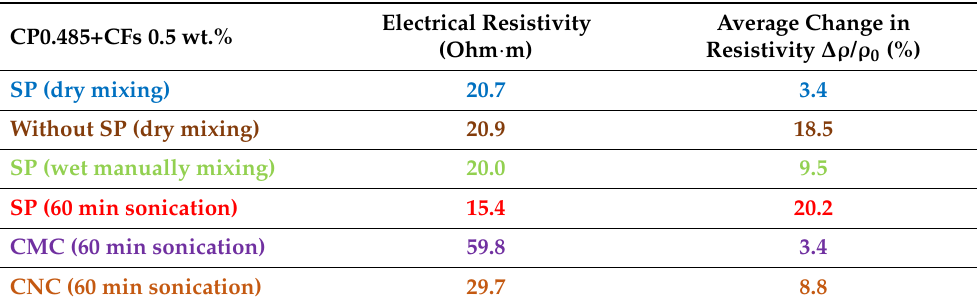
Table 2. Electrical resistivity values and average change in resistivity ∆ ρ / ρ 0 (%) of 28-day plain and cement paste micro-composites reinforced with